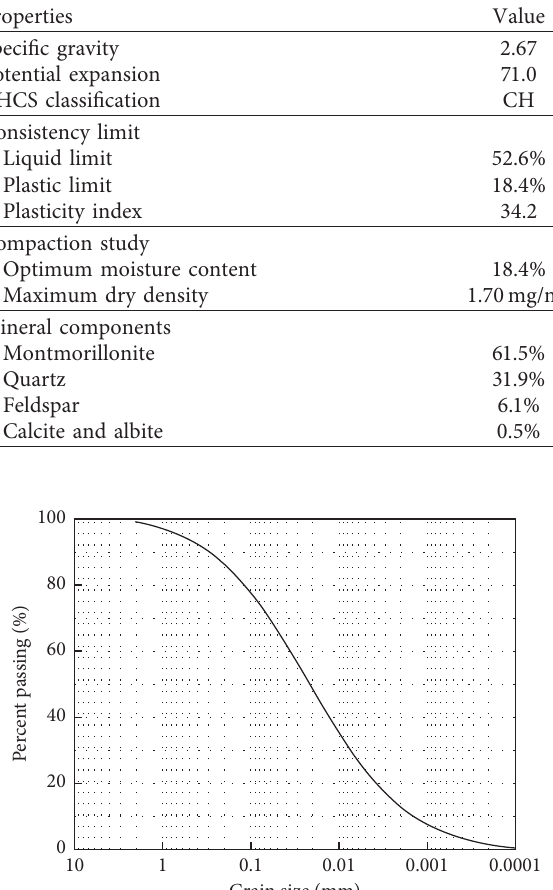
Table 1: Fundamental properties of mudstone material.